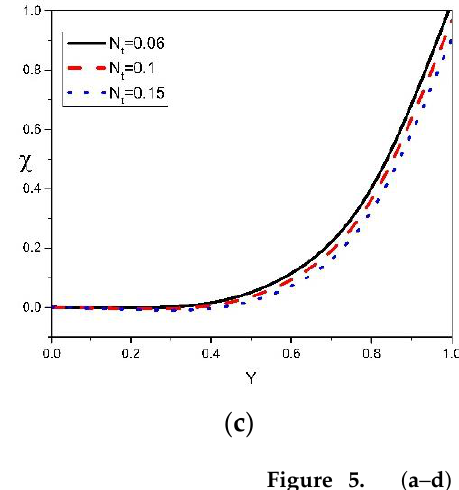
= 0.7, N = 0.7, N = 0.5, N t = 0.5, CT TC b